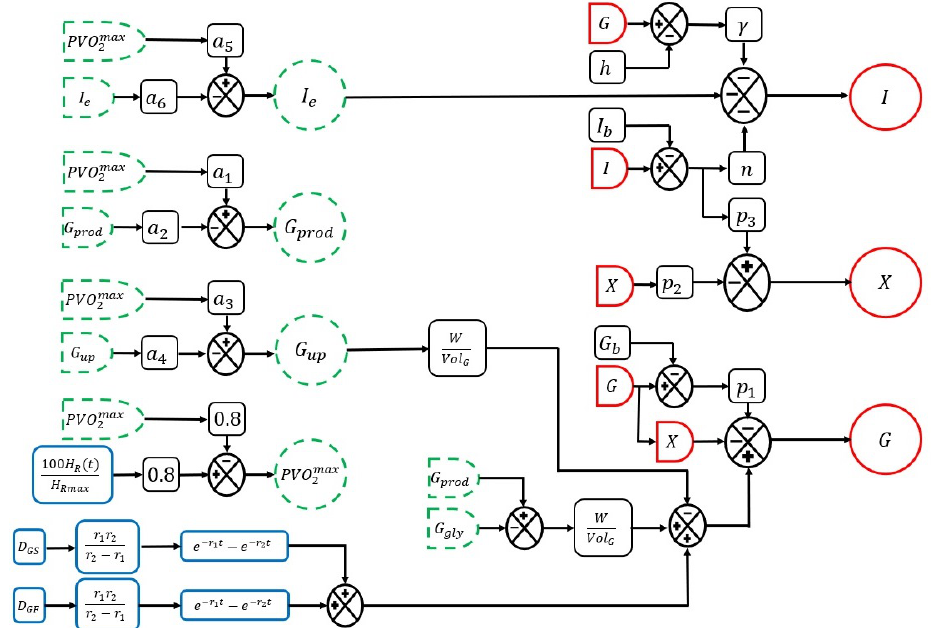
Figure 1. Proposed mathematical representation of glucose homeostasis in healthy people. The time-varying equations are enclosed by a circle and labels are placed on them to make the diagram more understandable. The expressions enclosed in a black box are the system parameters and those enclosed in a blue box represent the inputs and disturbances of the